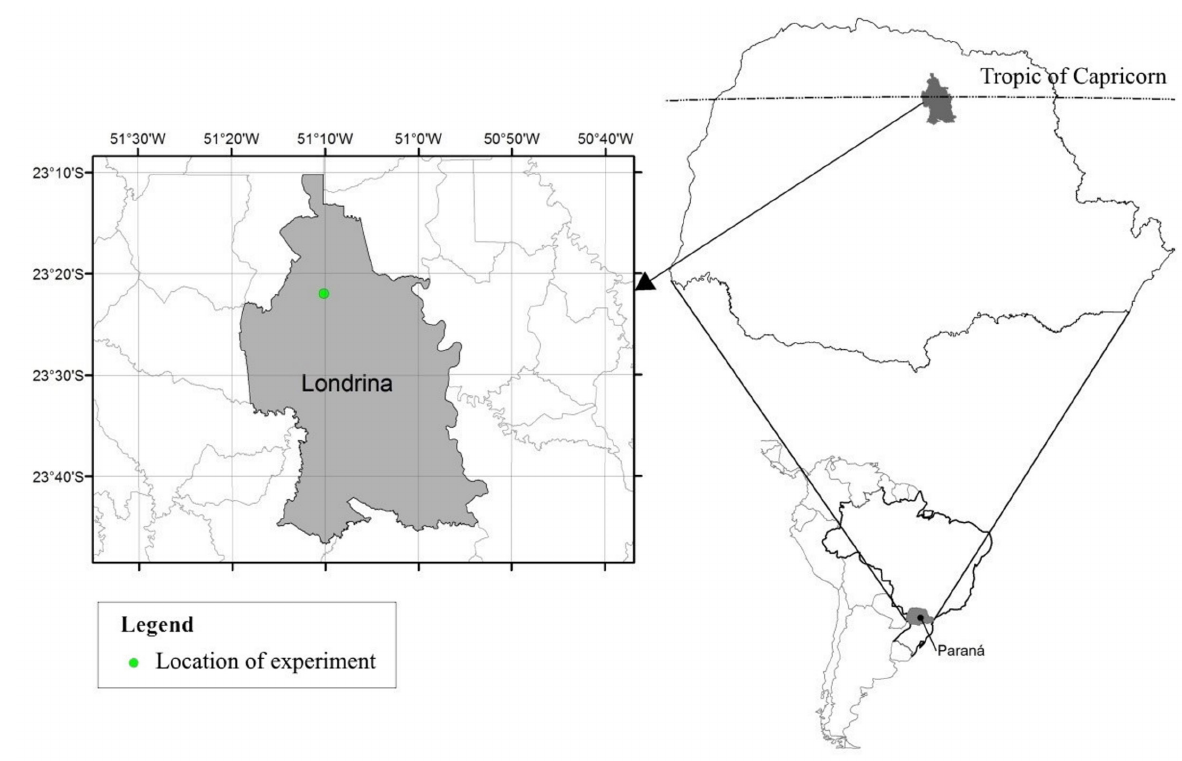
Figure 1. Location of experimental